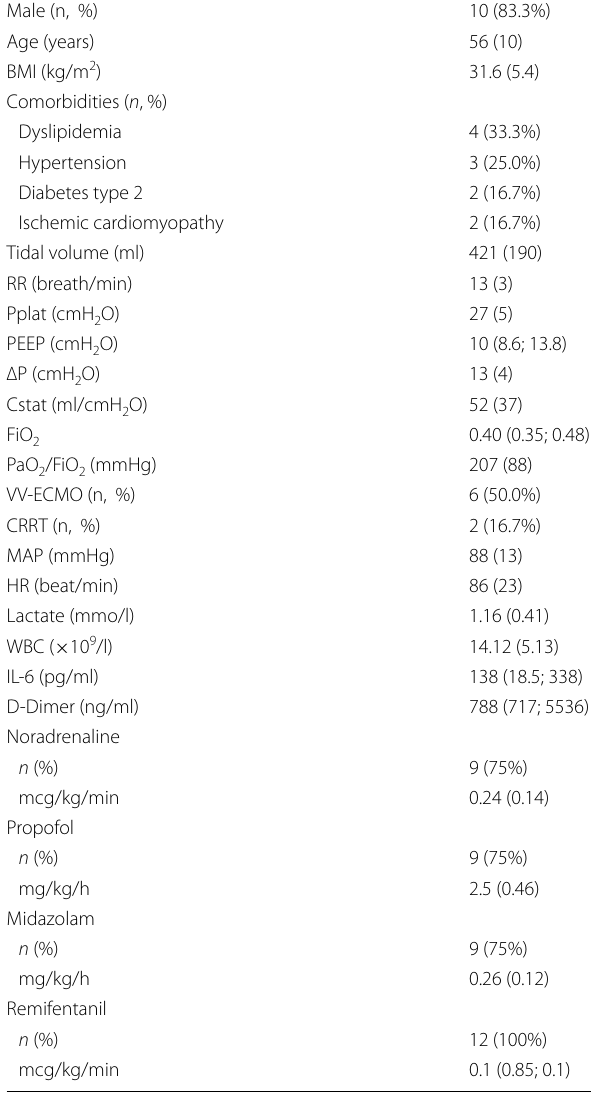
Table 1 Patients’